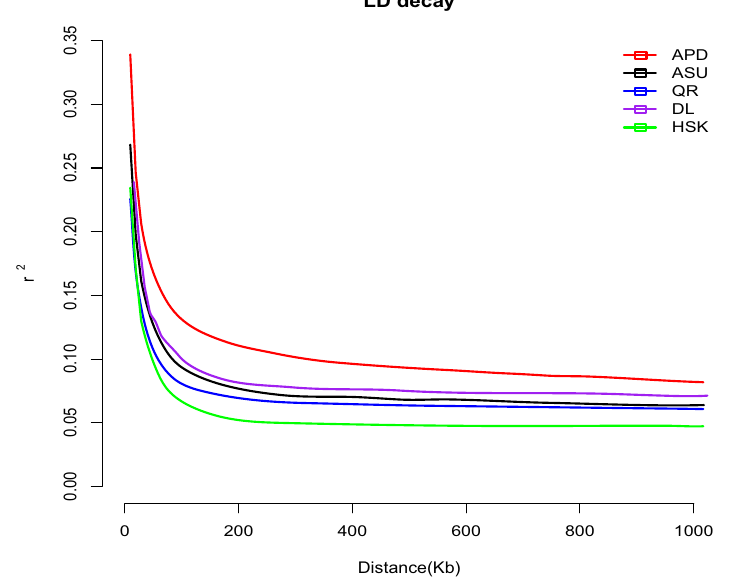
Figure 4. LD attenuation diagram of 5 sheep breeds. The X-axis represents the physical distance, while the Y-axis represents the linkage disequilibrium coefficient. Red represents APD, black represents ASU, blue represents QR, purple represents the DL, and cyan represents HSK.